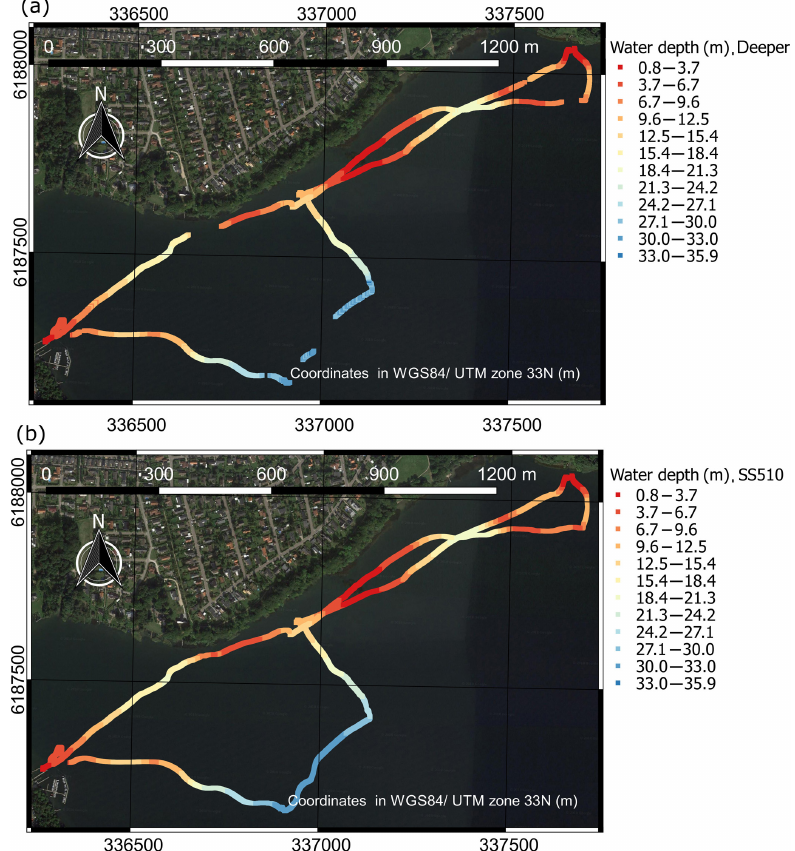
Figure 6. Water depth measurements retrieved in Furesø by the two sonars: (a) observations with Deeper sonar; (b) observations with SS510 sonar.